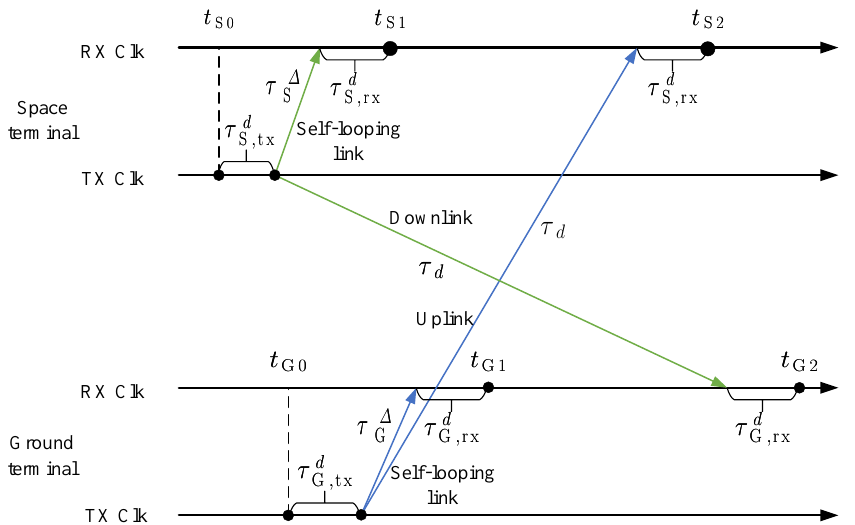
Figure 3. Time relationships for